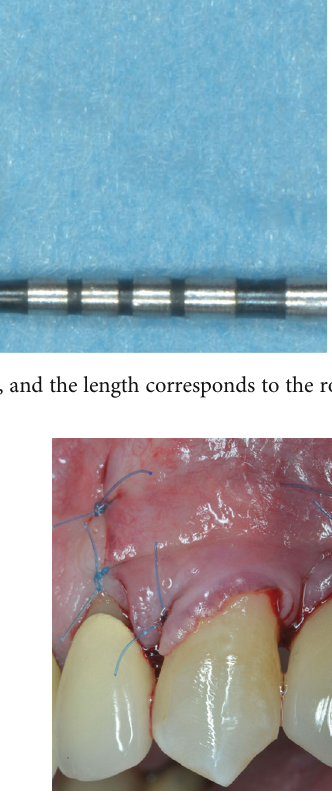
Figure 11: The fl ap has been coronally advanced and sutured.